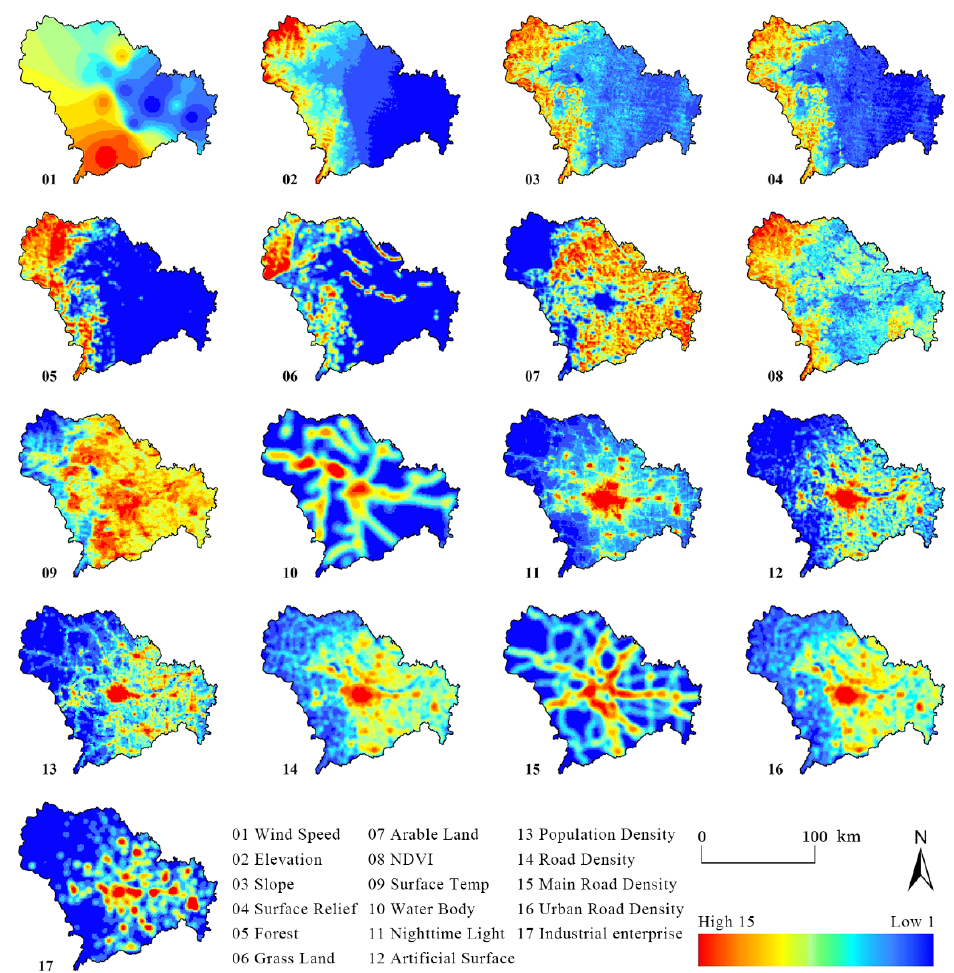
Figure 3. Results of standardized classification of variables.